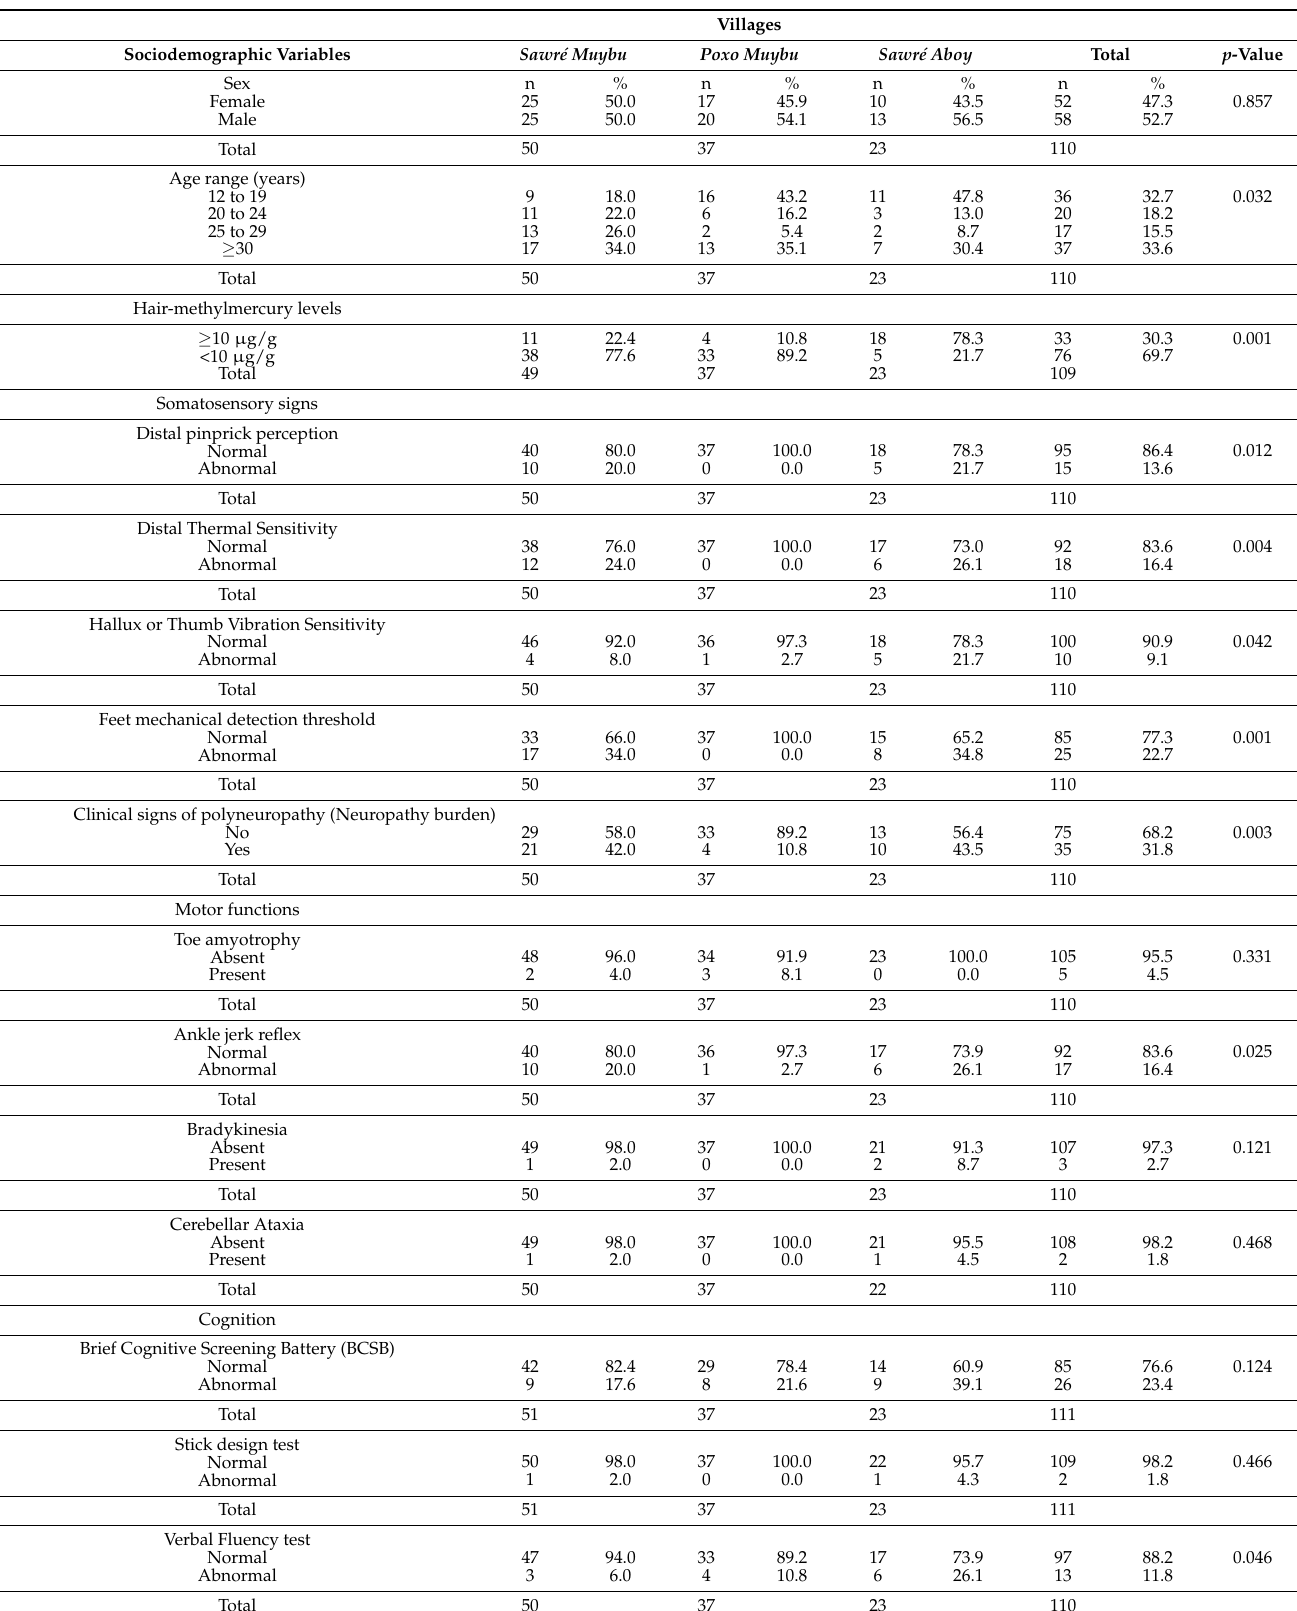
Table 1. Sociodemographic variables, hair-methylmercury level groups, somatosensory and motor functions, and cognitive alterations, according to the village of residence. Sawr é Muybu Indigenous Land, Par á state, Brazilian Amazon, 2019. Villages Sociodemographic Variables